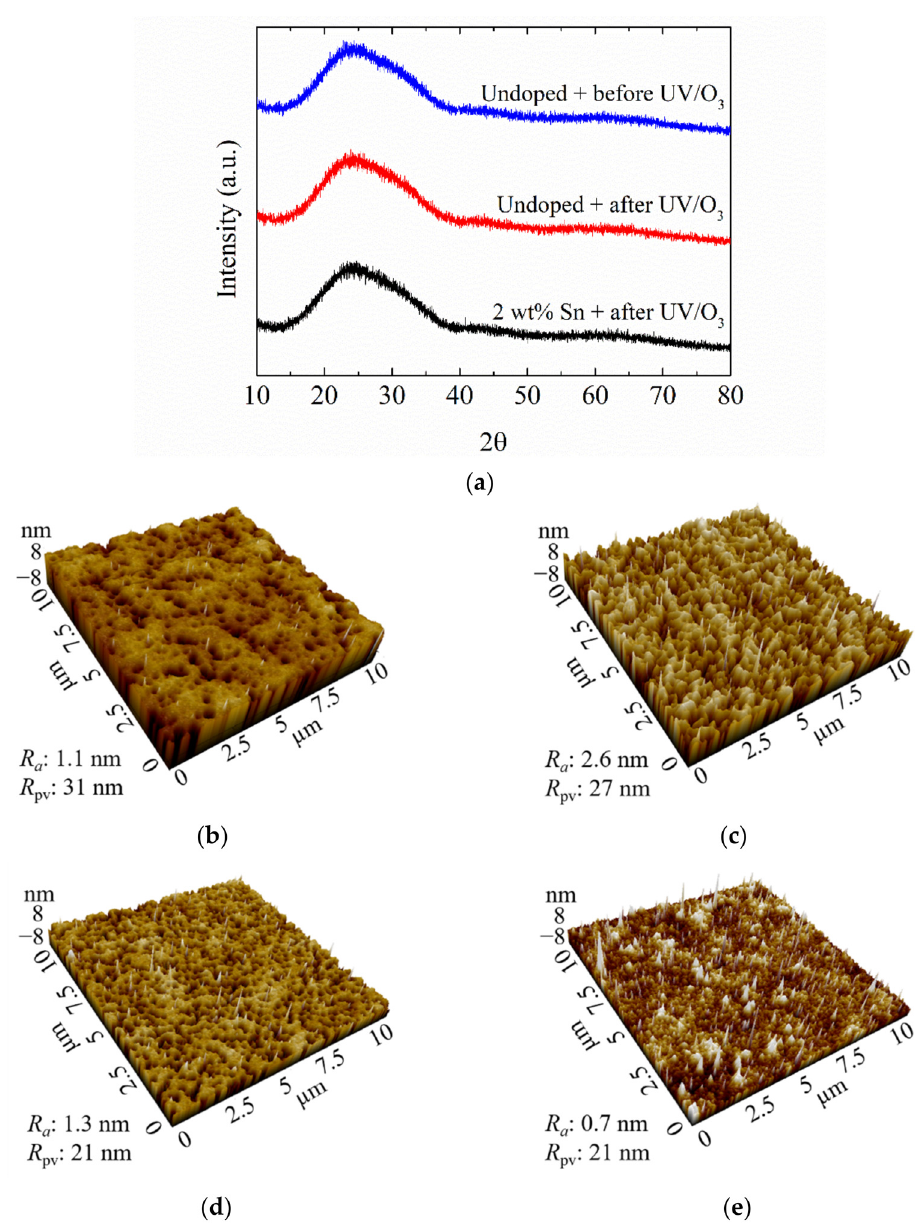
Figure 9. ( a ) XRD patterns of NiO films and AFM images of ( b ) undoped, ( c ) 0.5 wt%, ( d ) 1 wt%, and ( e ) 2 wt% Sn-doped NiO